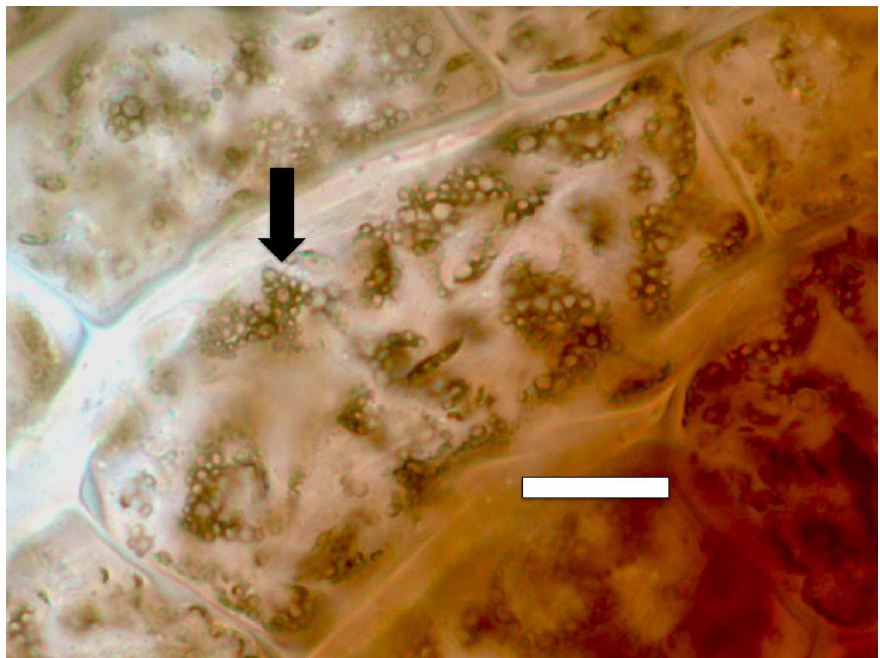
Figure 7. Amaranthus viridis seedling root cells stained with diaminobenzidine tetrahydrochloride (DAB) to show hydrogen peroxide (brown color) around clusters of bacterial protoplasts (arrow; bar = 15 µm).